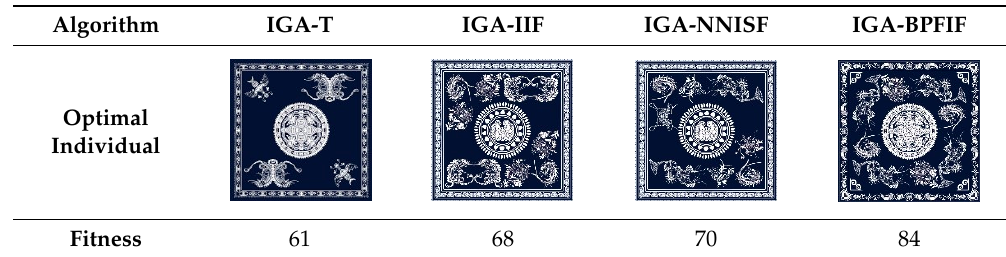
Table 2. Optimal result in the 10th generation.